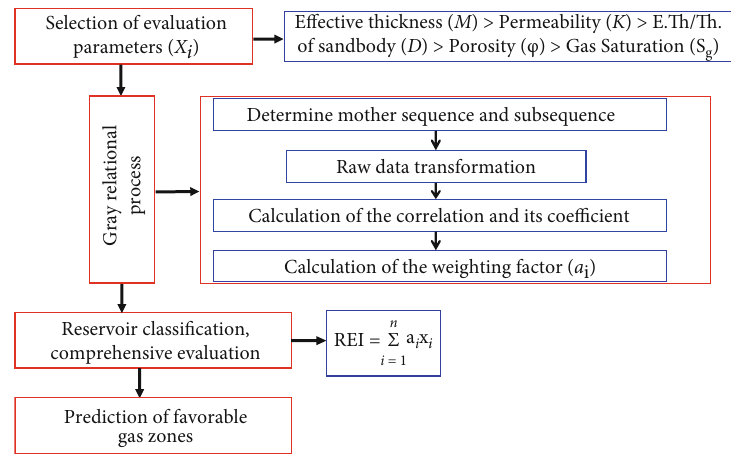
Figure 4: The brief process of gray relational